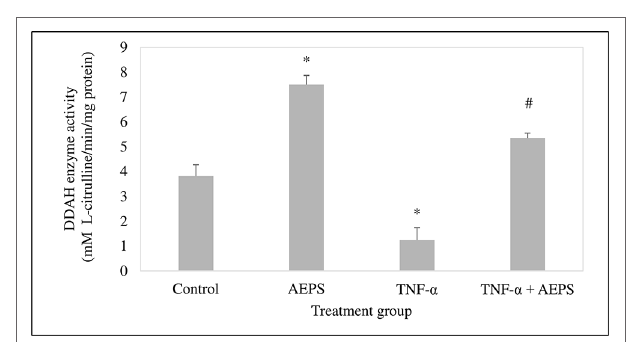
FIGURE 7 | Nitric oxide level in human umbilical vein endothelial cells (HUVEC). Data shown as mean ± SEM, n = 6 [*** P < 0.001 compared with the control group, ### P < 0.001 compared with the tumor necrosis factor (TNF)- α